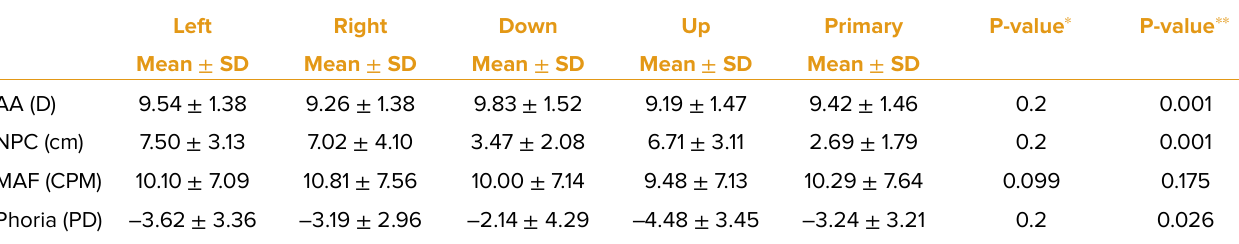
Table 2. The mean and standard deviation (SD) of indices in different gazes Left Right Down Up Primary P-value ∗ P-value ∗∗